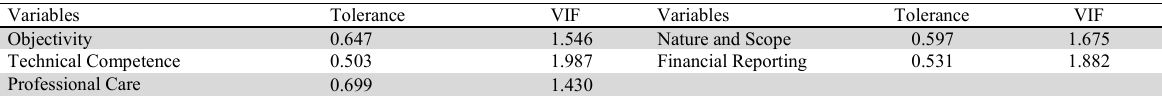
Multicollinearity Diagnoses of Qualitative Characteristics Variables